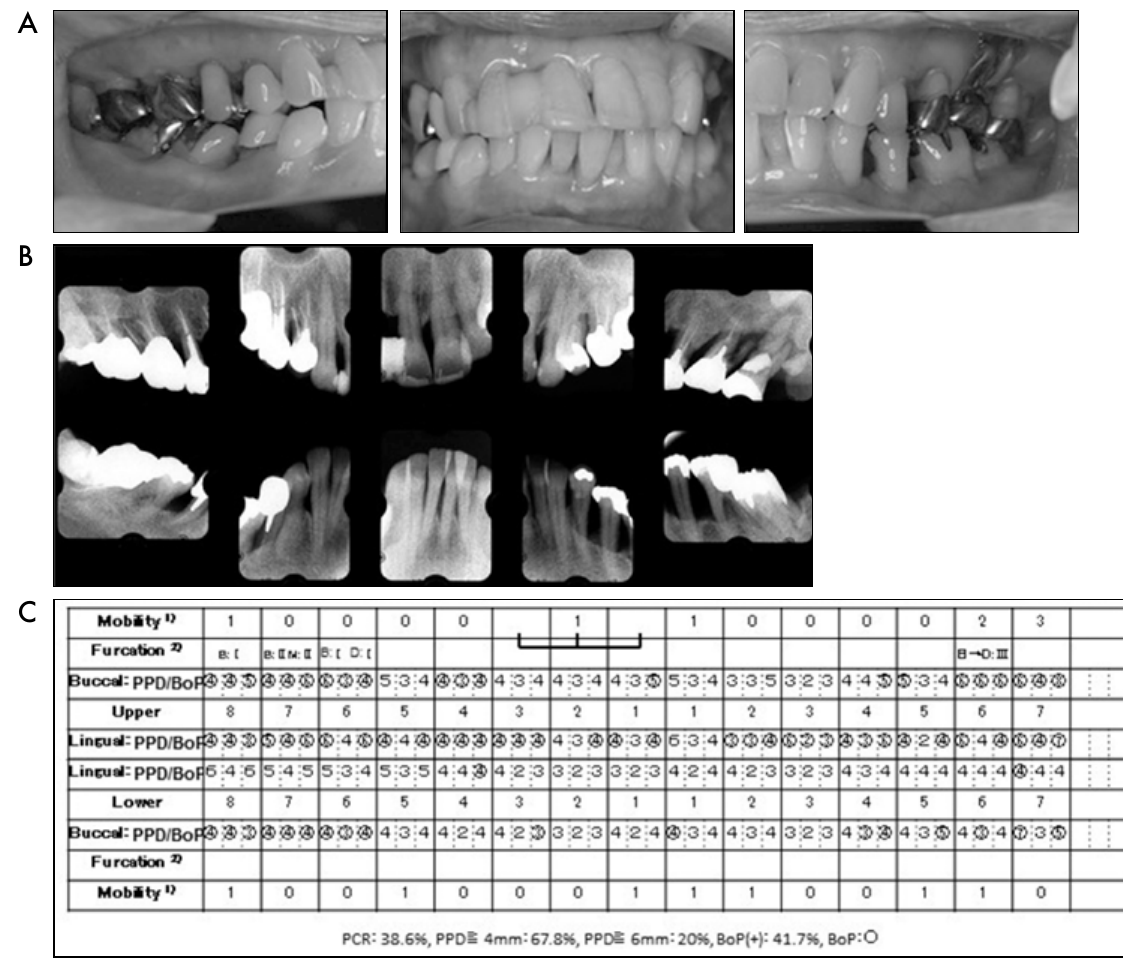
Figure 1. Initial examination. A: Intraoral Photographs. Front and side views of the dentitions. B: Periapical radiographs. C: Periodontal chart. 1) According to the classification by Miller (1964), 2) According to the classification by Hamp et al. (1975). PPD: Probing Pocket Depth, BoP: Bleeding on